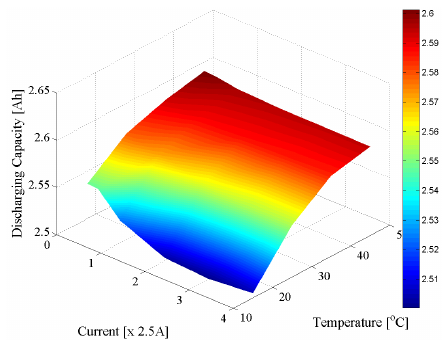
Figure 4. Dependence of the discharged capacity on temperature and load current.